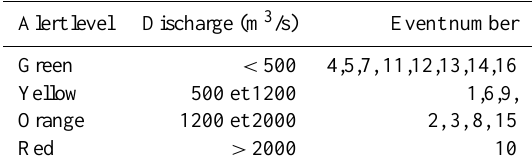
Table 2. Alerts levels of the SPC-GD at Anduze.